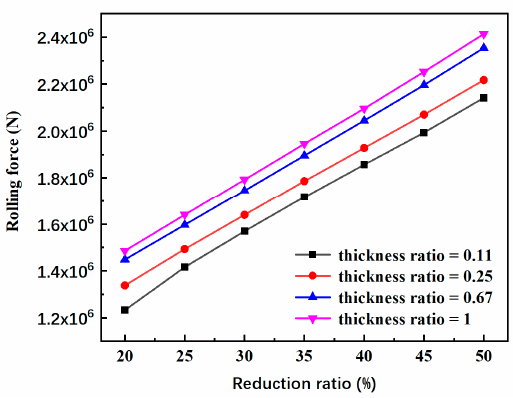
Figure 6. Changes in rolling force vs. reduction ratio of the clad plate.